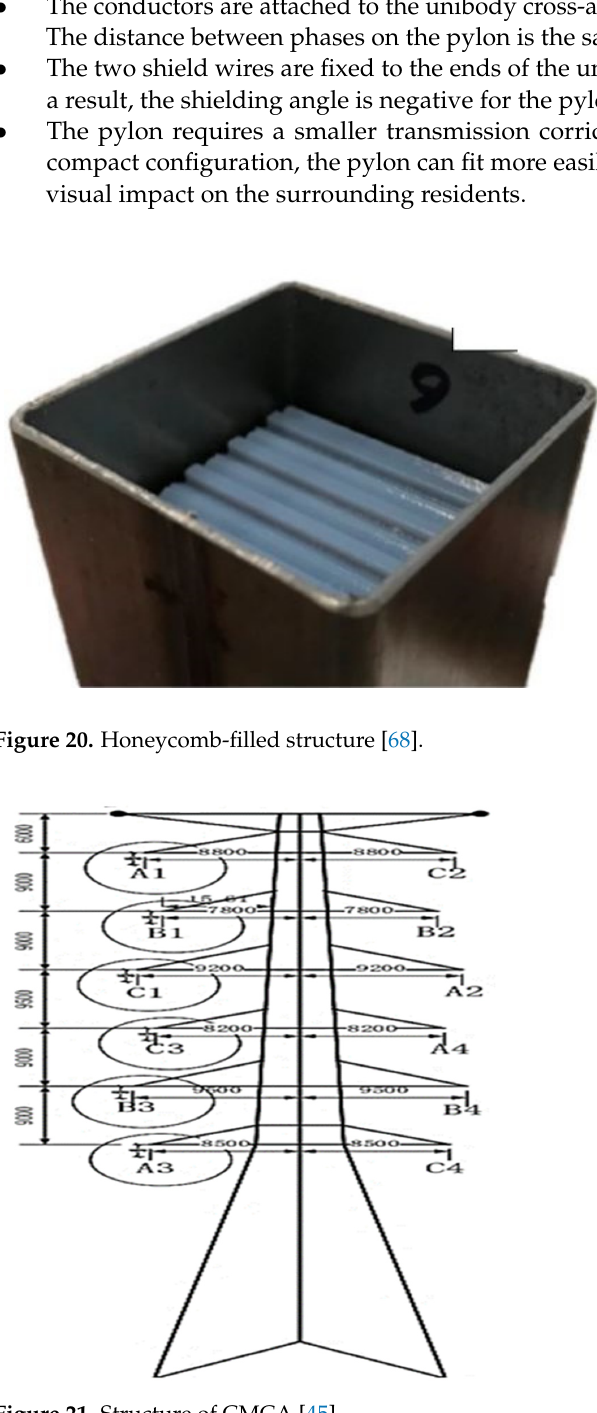
Figure 21. Structure of CMCA